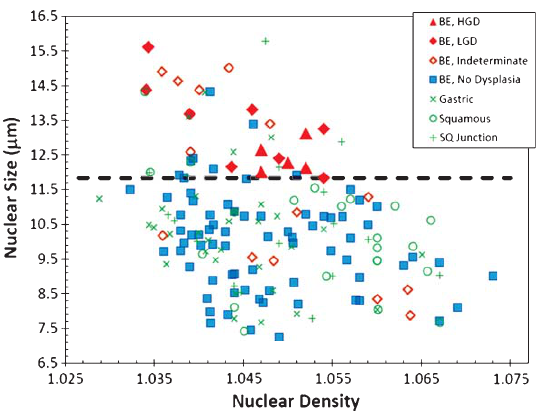
Fig. 7. In vivo basal layer scatter plot for BE study. Each point rep- resents a single optical biopsy and is color-coded by its pathological diagnosis. Dotted black line represents decision line. Taken from Ref.